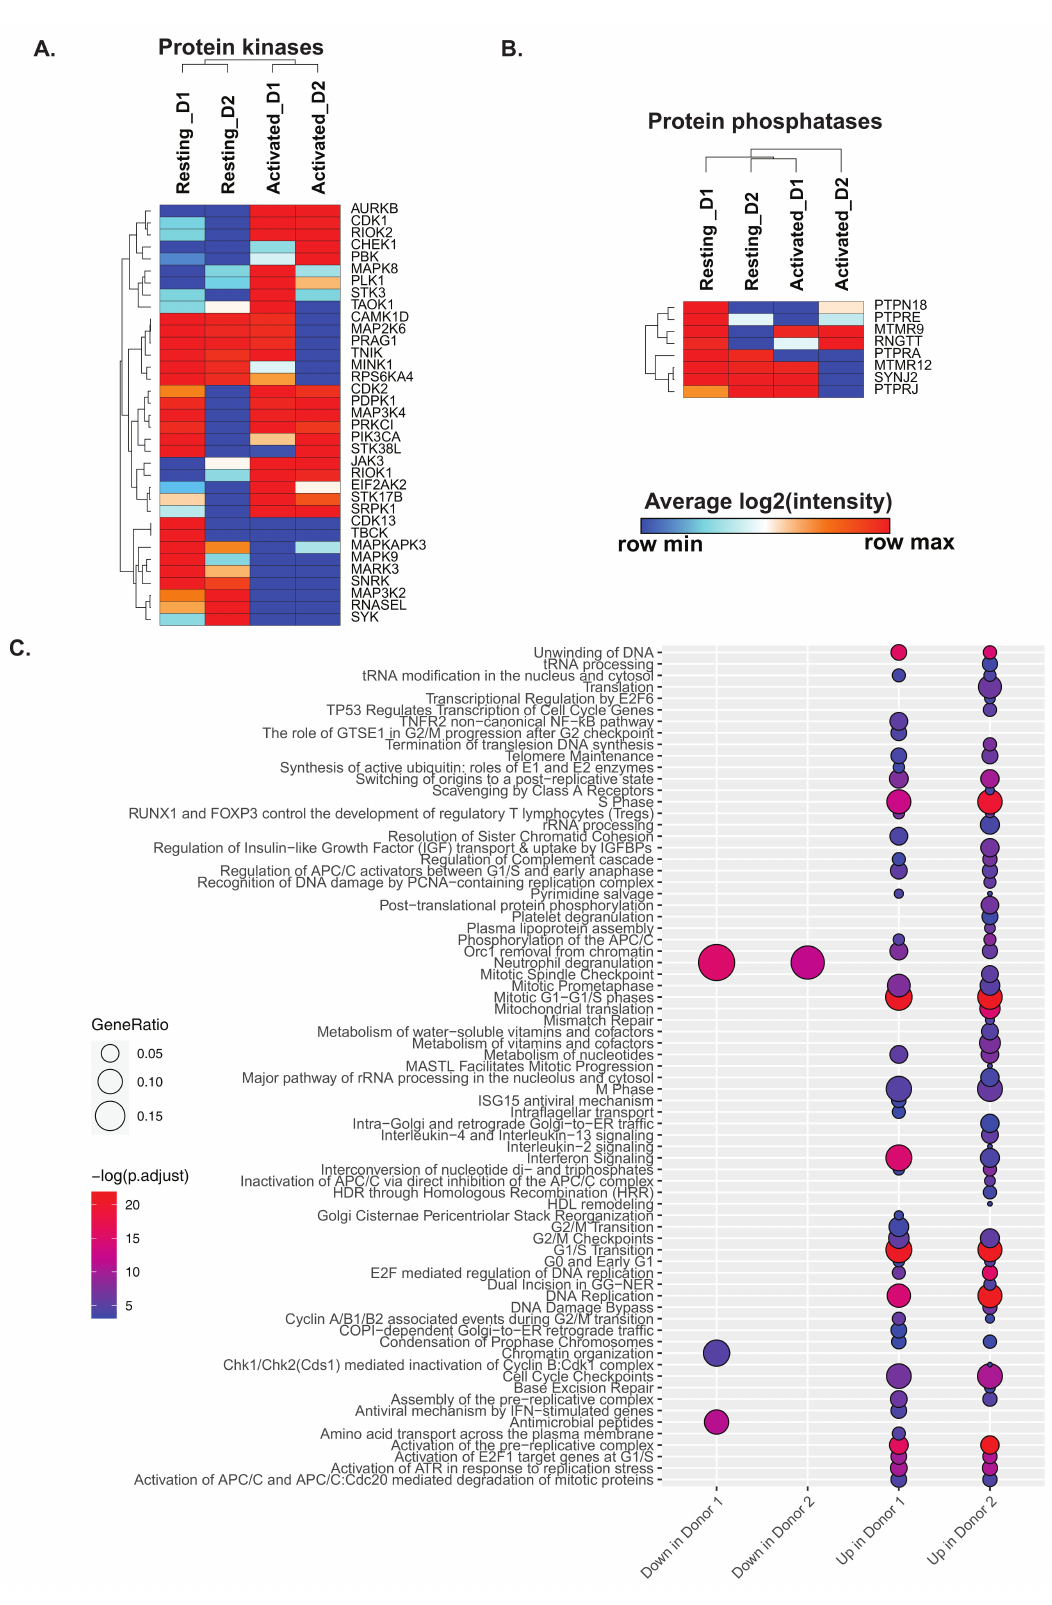
Figure 3. Heatmaps depicting changes in ( A ) protein kinases and ( B ) protein in CD4+ T cells in response to activation. Genesets for comparison of significantly changing proteins were obtained from MSigDB. ( C ) Significantly changing signaling pathways in resting and activated CD4+ T cells after pathway enrichment using Reactome